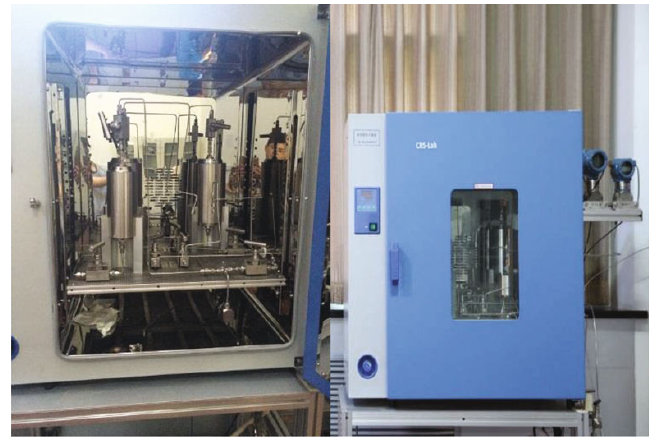
Figure 2: PTM permeability measurement apparatus (pressure transmission decay